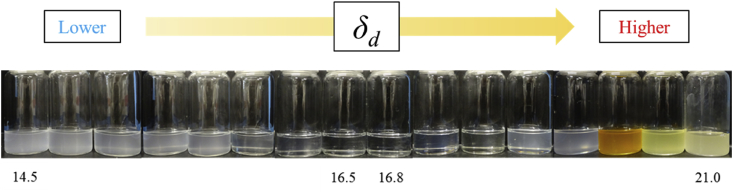
Dispersion state of model particles with various organic solvents.